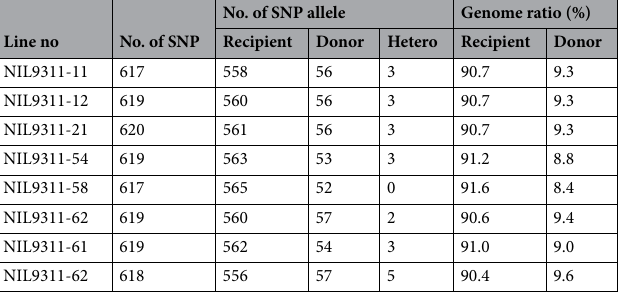
Table 4. Genome recovery rate of eight improved homozygous plants from NIL9311 population.